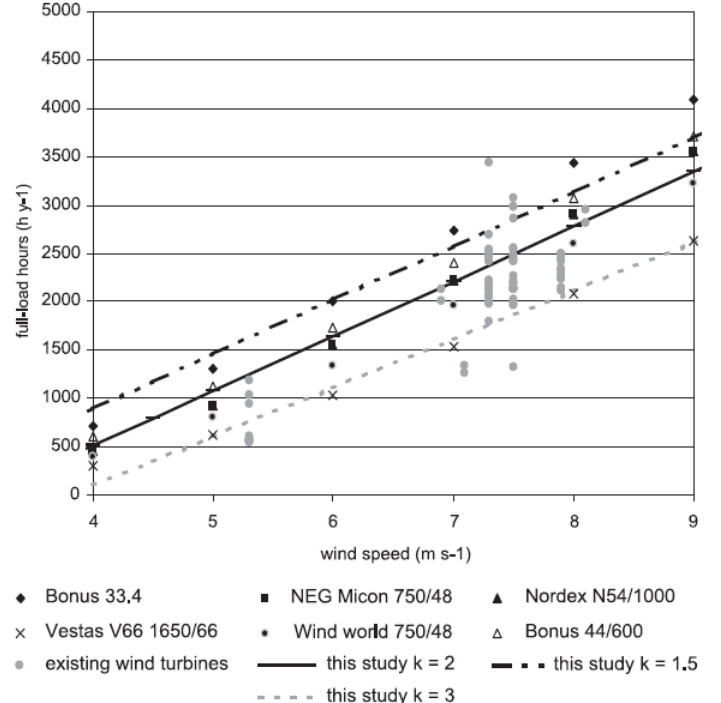
Figure 44. Average capacity factor as a function of wind speed. Most turbines operate in a range between 2000 and 3000 full load hours, which is equivalent to capacity factors between 23% and 34% (© 2004 Elsevier, reproduced with permission from [198]). For wind farms at certain windy sites, average capacity factors of up to 45% are reported